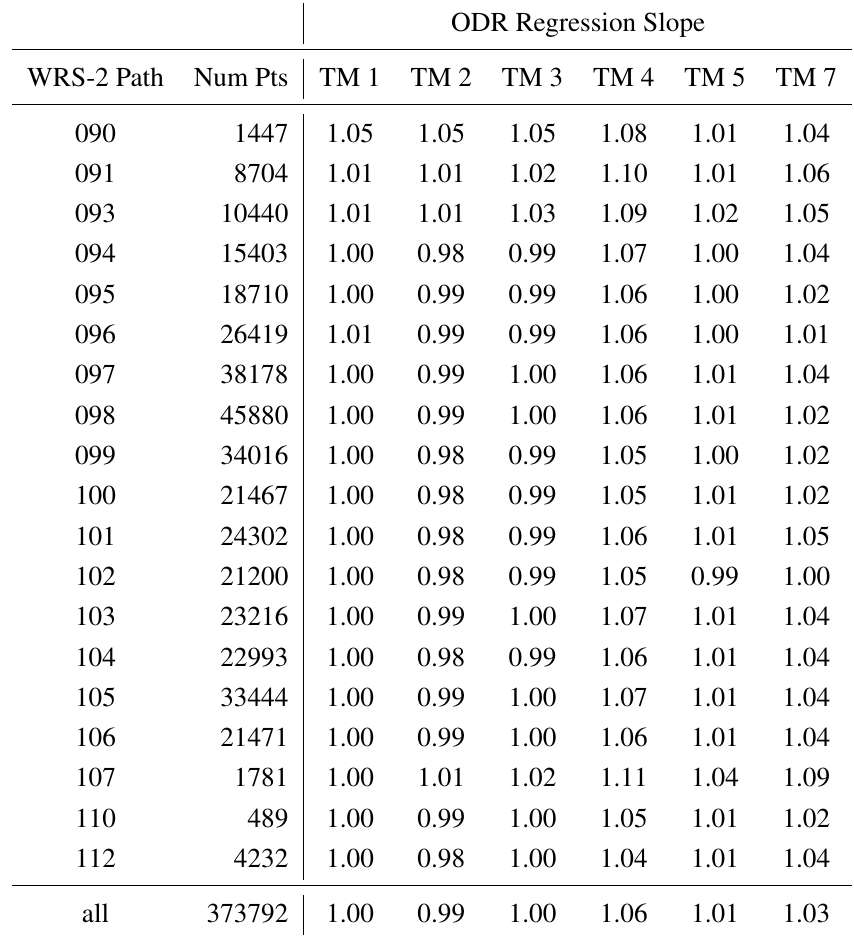
Table 3. ODR regression slopes between ETM+ and OLI top-of-atmosphere reflectance, for all available scenes in each WRS-2 path. Band columns are labelled with their Thematic Mapper (TM)